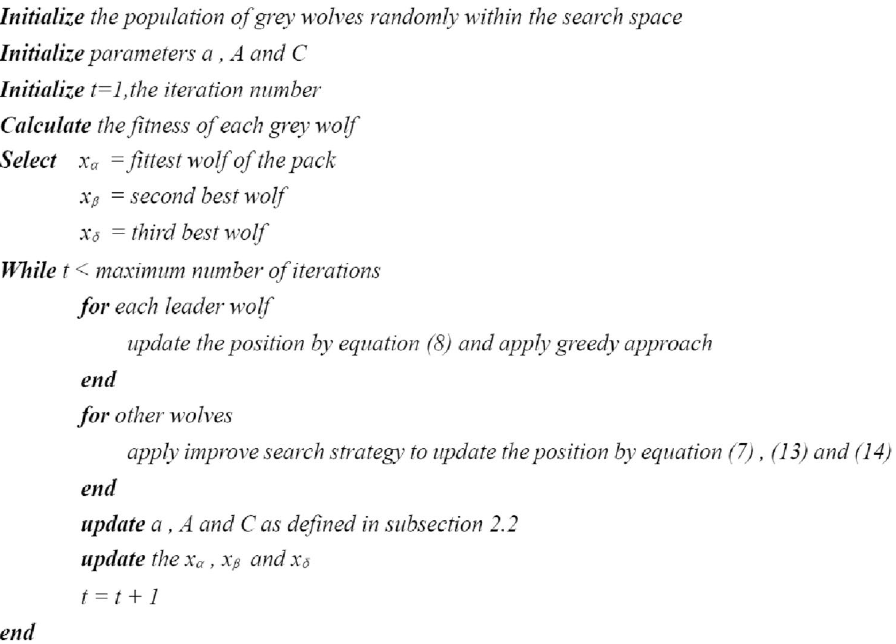
Figure 3. The pseudo code of CG-GWO